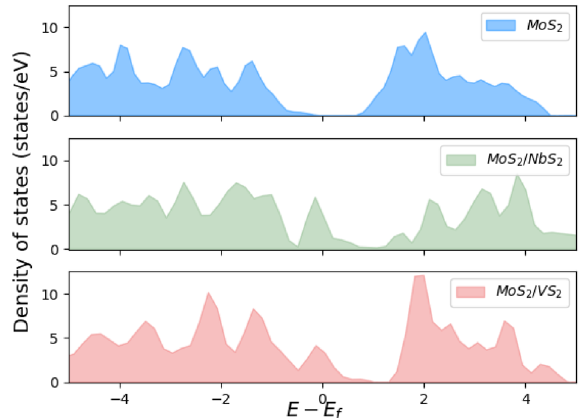
Figure 8. The density of states (DOSs) plots of 2H-MoS 2 (top), 2H-MoS 2 /2H-NbS 2 (middle), and 2H-MoS 2 /2H-VS 2 (bottom). Here, E f denotes the energy of the Fermi